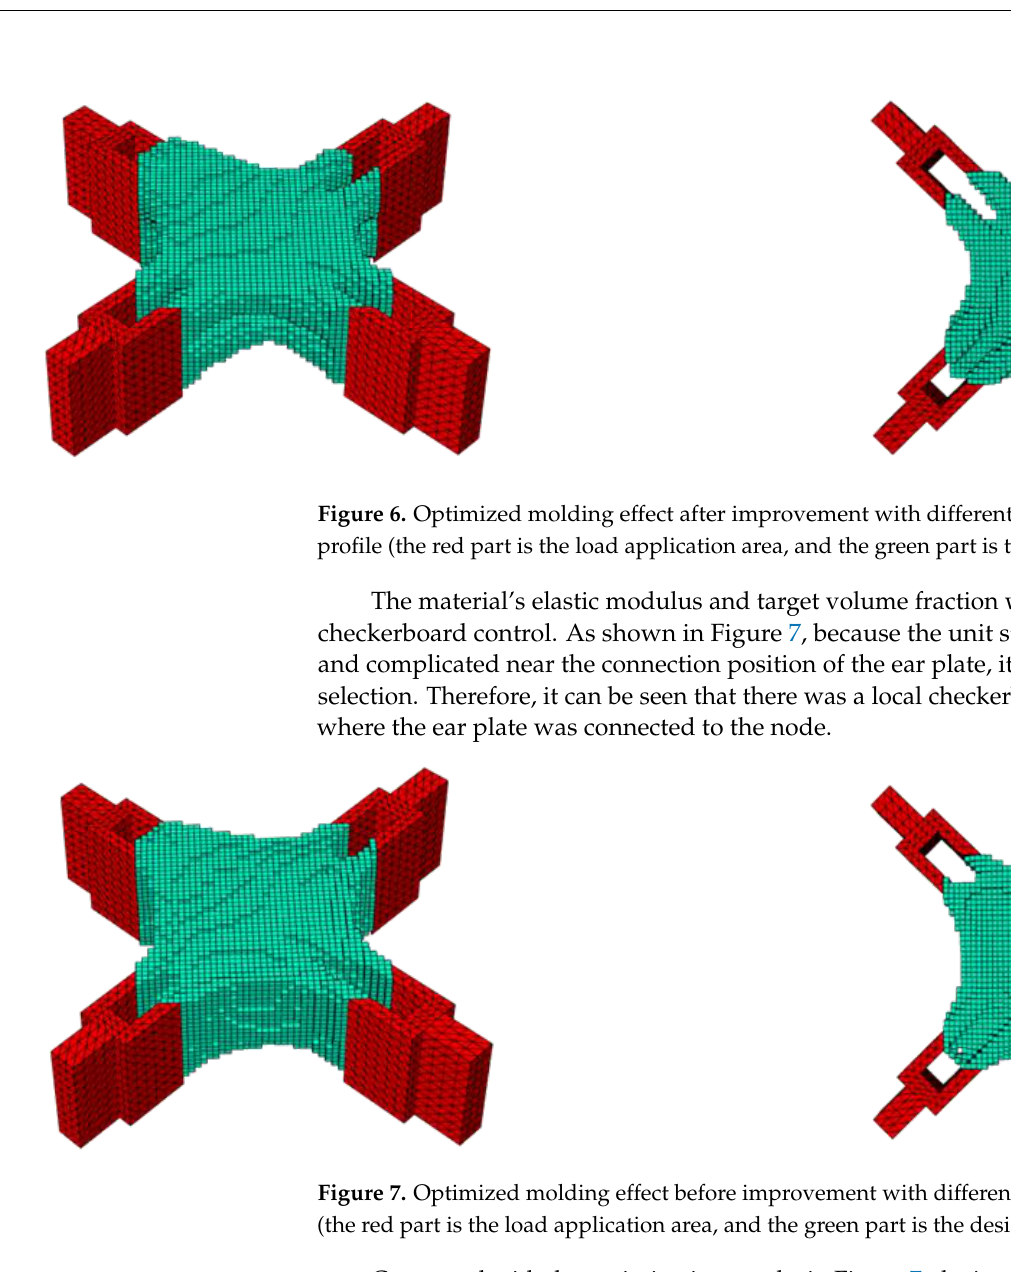
( b ) Figure 8. Schematic diagram of optimization results under axial load conditions: ( a ) cutaway view; ( b ) stress nephogram.